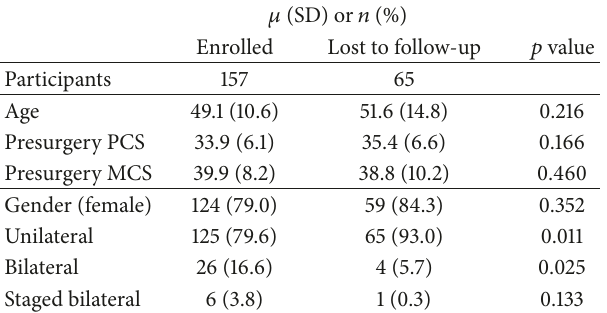
Table 2: Patient demographics for all patients in mission years